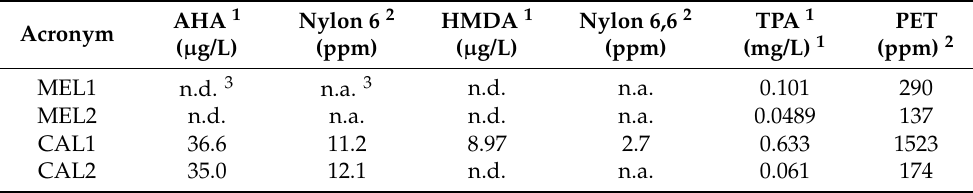
Table 6. Concentration of PA’s monomers and relative polymers in sediment sample.